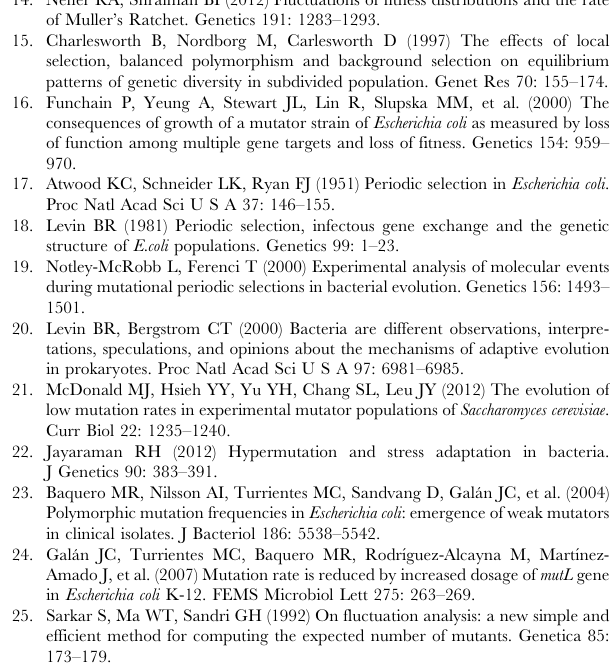
Table S2. Table S1. Complementation of the ancestor strain with genes commonly involved in the mutator phenotype. Table S2. Mutation rates of the Escherichia coli ECU24 original strain (t 0 ), an evolved normo-mutable variant and an evolved mutator variant (both from t 151 passage) over-expressing Nei, SodB, and